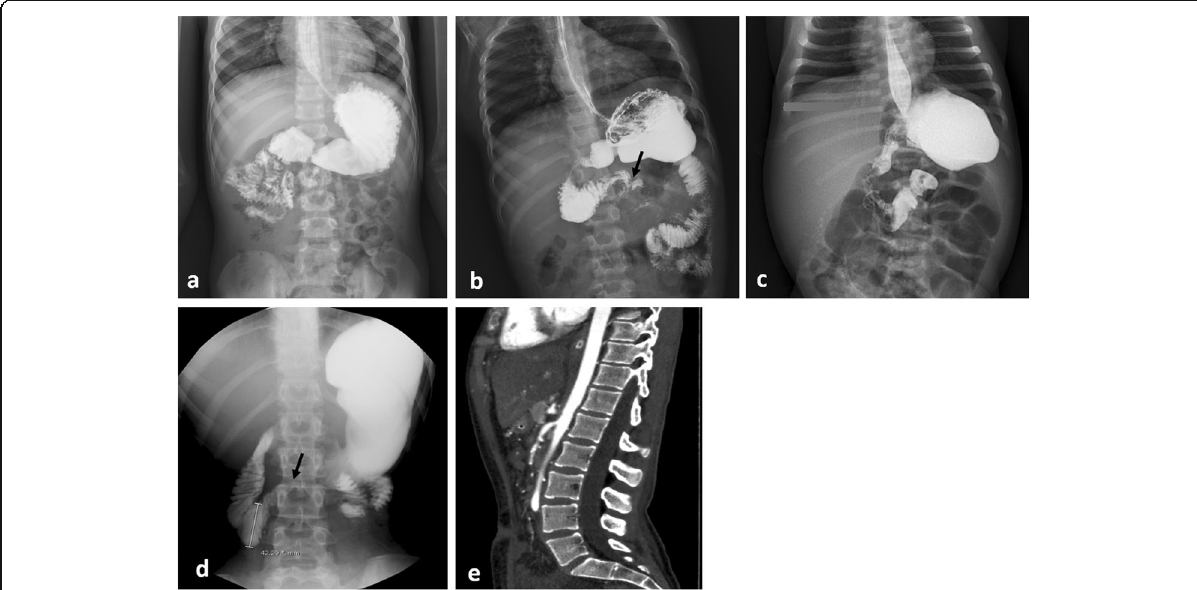
Fig. 3 Upper gastrointestinal series of four different patients presenting with bilious vomiting; the upper row shows three different patterns of malrotation a ) the jejunum is seen in the right side of the abdomen; b ) the duodenojujenal junction is seen at a lower level than the duodenal bulb with cork-screw appearance of the proximal jejunal loops (arrow); c ) malrotation accompanied by organoaxial gastric volvulus. d , e ) A case of superior mesenteric artery syndrome showing persistent filling defect at the third part of duodenum; sagittal CT angiography showing decreased aortomesenteric angle